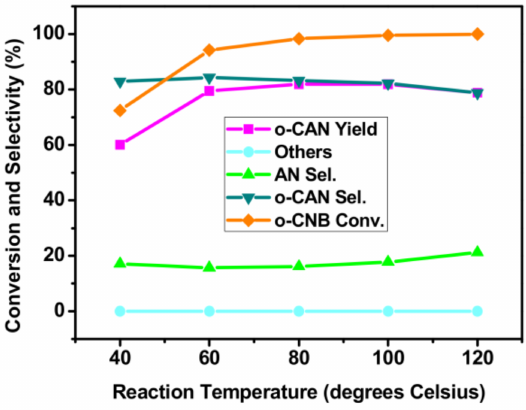
Figure 9. Dependence of the o -CNB hydrogenation upon reaction temperature. Conditions: P(H 2 ) = 1 MPa, 0.5 h, m cat. = 20 mg, n o -CNB /n Pd = 9000:1, V ethanol = 5